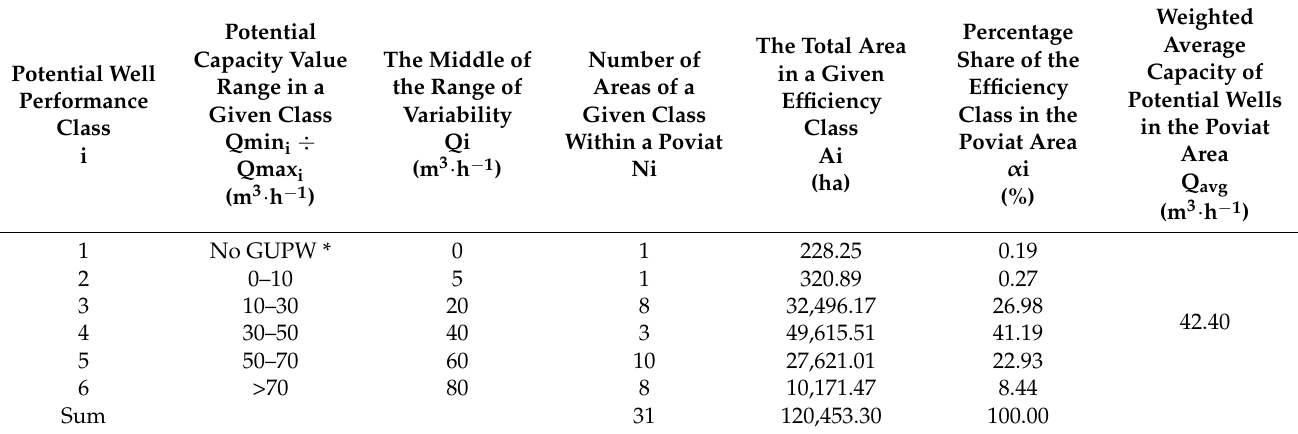
Table 3. Characteristics of groundwater resources in Braniewo poviat based on the analysis of the potential capacity of a drilled well containing the main usable groundwater level.